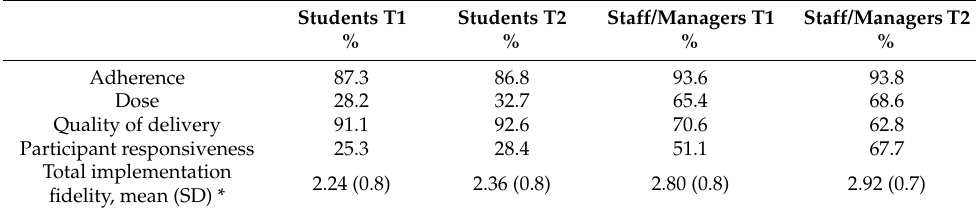
Descriptive results regarding implementation fidelity at T1 and T2—proportion of